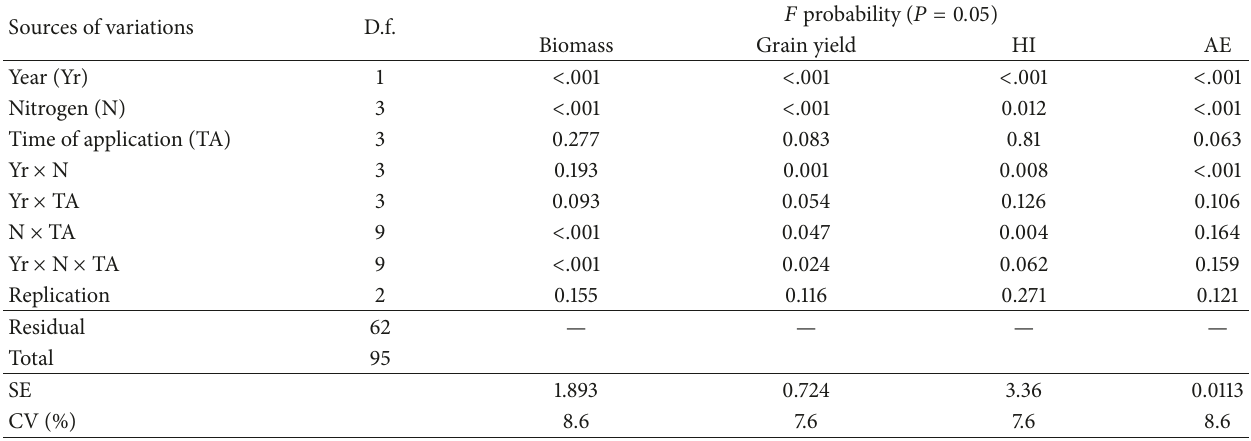
Table 1: Analysis of variance for yield and yield components of maize as influenced by N rates, time of application, and the interaction effects in 2013 and 2014 at Bako, Western Ethiopia. Sources of